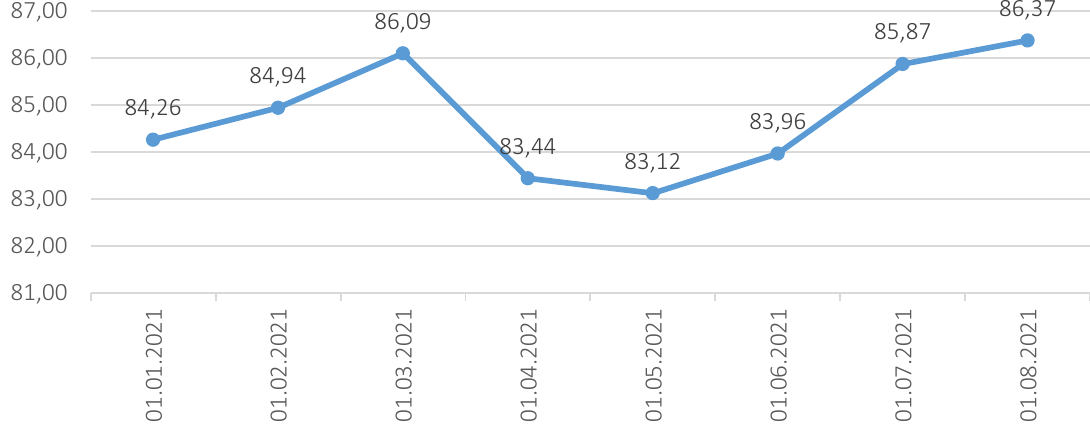
Figure 7. Forecasted amount of Ukraine’s state debt, USD